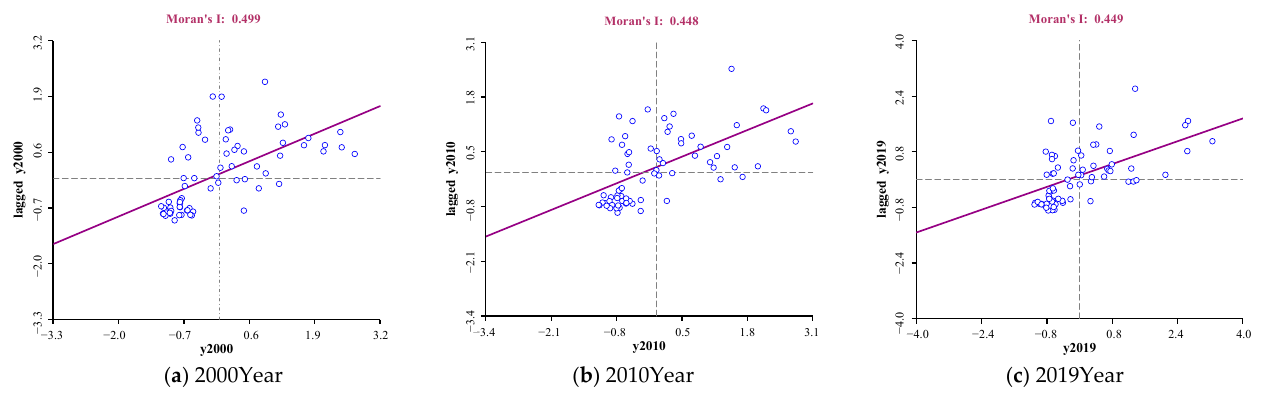
( c ) 2019Year Figure 4. Spatial distribution of the 𝐴𝑊𝐹 (cid:3034)(cid:3045)(cid:3032)(cid:3052) in the Yellow River Basin from 2000 to 2019. 3.2. Spatial and Temporal Characteristics of the 𝐴𝑊𝐹 (cid:3034)(cid:3045)(cid:3032)(cid:3052) in the Yellow River Basin This study calculated the global autocorrelation Moran’s I index of the 𝐴𝑊𝐹 (cid:3034)(cid:3045)(cid:3032)(cid:3052) of